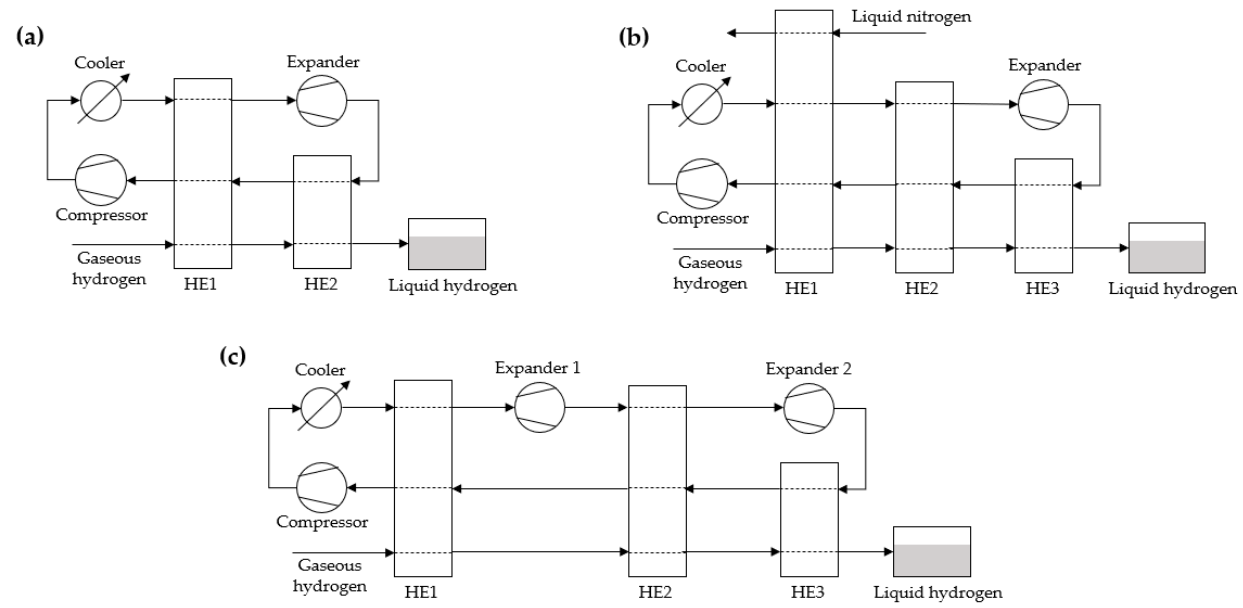
Figure 8. Basic schematic diagram of Brayton cycle for hydrogen liquefaction: ( a ) simple helium Brayton cycle; ( b ) helium Brayton cycle with liquid nitrogen pre-cooling, and ( c ) two-step helium Brayton cycle